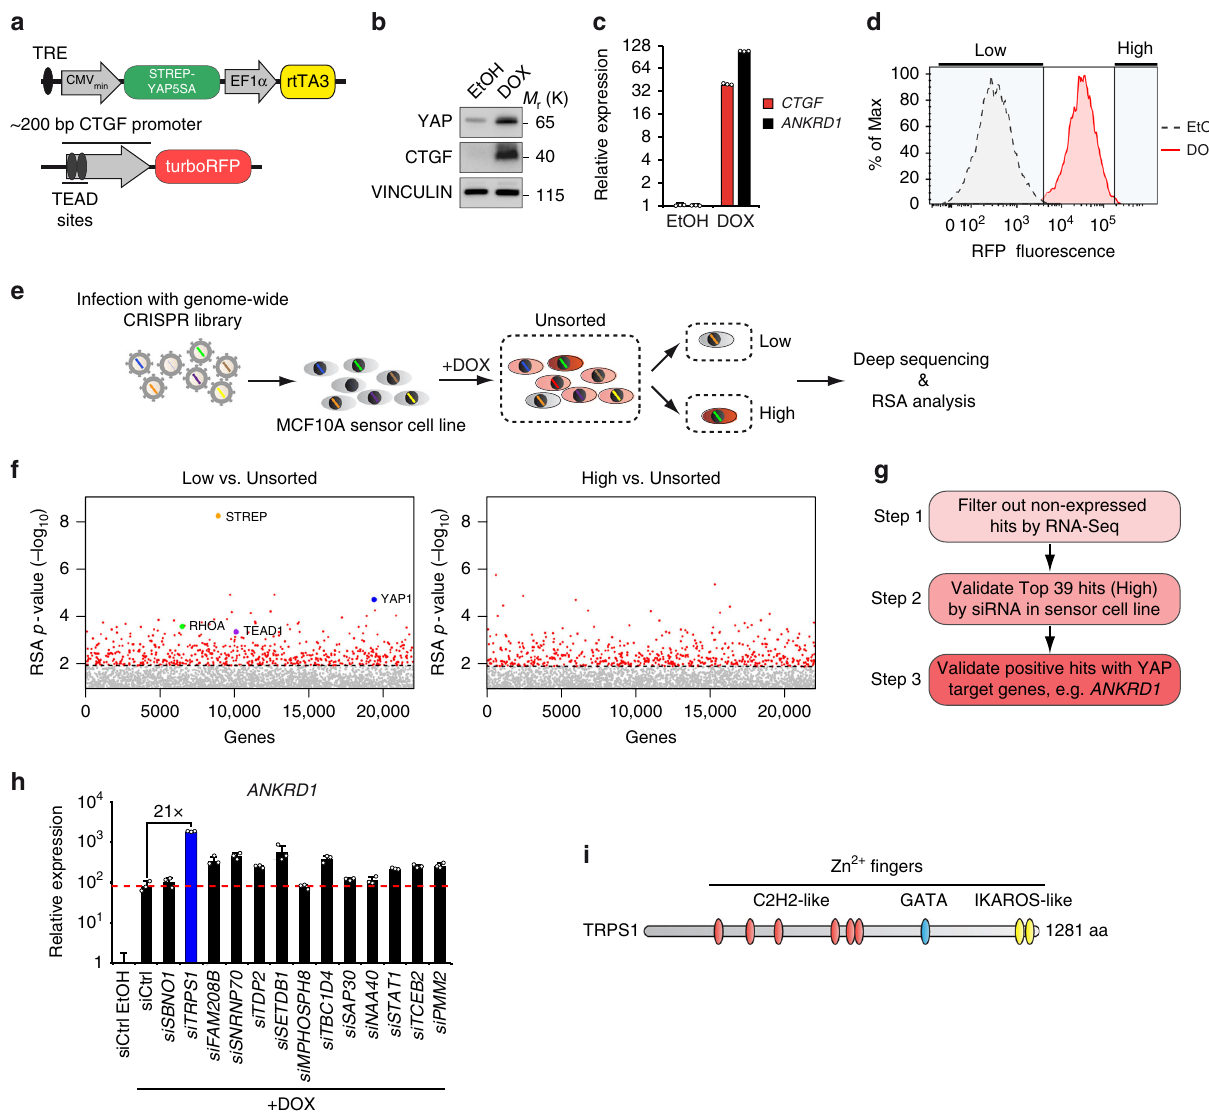
Fig. 1 Identi fi cation of the YAP modulator TRPS1 using a genome-wide CRISPR screen. a Schematic of the YAP activity sensor system. The sensor cell line harbours a doxycycline inducible Strep-YAP5SA allele and a turboRFP (red fl uorescent protein) reporter under the control of a CTGF promoter fragment containing TEAD-binding sites. b Western blot for YAP and CTGF in sensor cells treated with doxycycline (DOX) or ethanol (EtOH). Vinculin serves as loading control. c qRT-PCR analysis of the sensor cell line for the YAP target genes CTGF and ANKRD1 . The cells were treated with doxycycline (DOX) or ethanol (EtOH). The chart summarizes three biological replicates. Error bars represent s.e.m. d Flow cytometry for RFP in the sensor cell line after treatment with doxycycline (DOX) or ethanol (EtOH), respectively. e Schematic of the CRISPR screening strategy. MCF10A sensor cells were infected with the genome-wide lentiviral GeCKO v2 CRISPR library. After doxycycline (DOX) treatment, cells were sorted into two subpopulations, “ high ” or “ low ” , representing 1% of the cells with highest or lowest RFP signal, respectively. Both populations were then analyzed by deep sequencing to determine the frequency of each sgRNA. f Plots for the distribution of P -values in the low vs. unsorted (left) and high vs. unsorted (right) cells, respectively, after analysis by the redundant siRNA activity (RSA) algorithm. g Work fl ow for the validation of candidates from the CRISPR screen. h qRT-PCR analysis of ANKRD1 expression in the doxycycline-treated sensor cell line transfected with siCtrl or siRNA targeting candidate YAP modulators. The cells were treated with doxycycline ( + DOX) to induce YAP 5SA expression or ethanol (EtOH) as a control. Data presented are means from technical triplicates and error bars represent s.d. i Schematic of the TRPS1